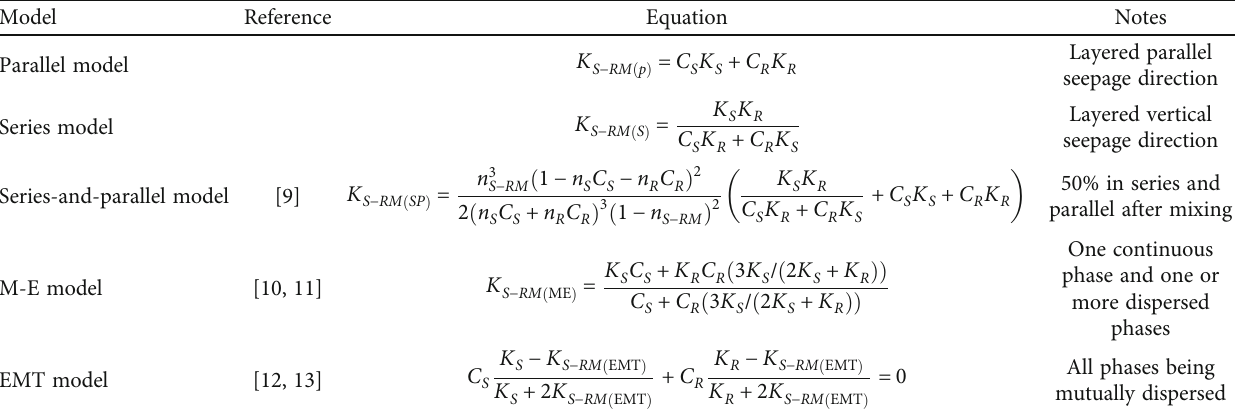
Table 1: The model of permeability coe ffi cient of SRM [7,